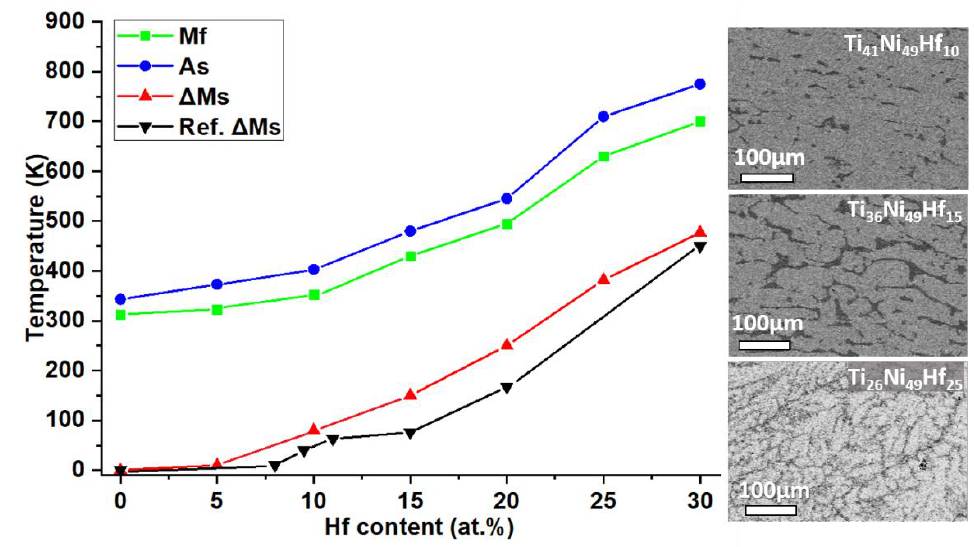
Figure 2. Influence of Hf content on the transformation temperature of Ti 51 Ni 49-X Hf X SDA built SMA at as-fabricated condition. The M f , A s and ∆M s are martensitic transformation finish temperature, austenite transformation start temperature and the difference between the M s of Ti 51 Ni 49-x Hf x and the M s of Ti 51 Ni 49 determined by the DSC experiment. The Ref. ∆M s is the difference between the M s of Ti 50 Ni 50-x Hf x and the M s of Ti 51 Ni 49 reported by literature [2].